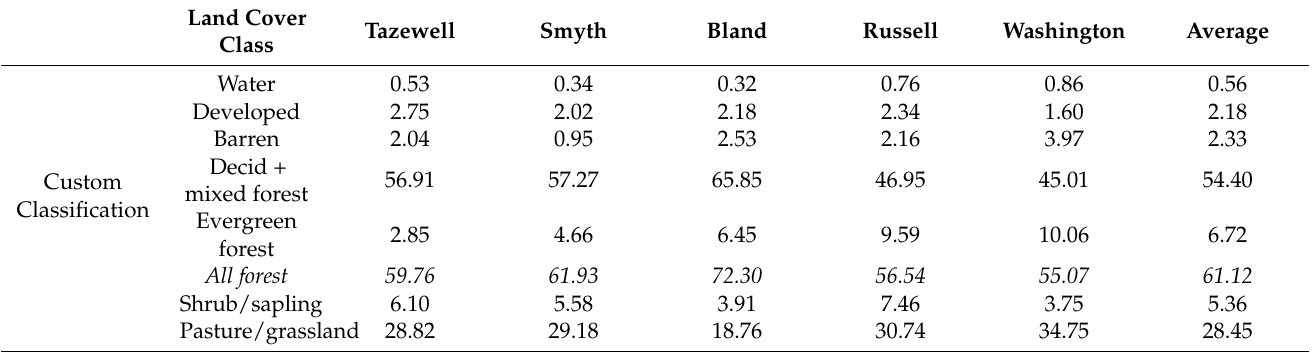
Table 3. Comparing percent cover from custom classification with two publicly available land cover classifications—30 m resolution NLCD and 1 m resolution VLCD. For our custom classification and NLCD, we added a category called All forest that is the sum of deciduous and evergreen forest cover types for ease of comparison with VLCD that does not distinguish these forest types.